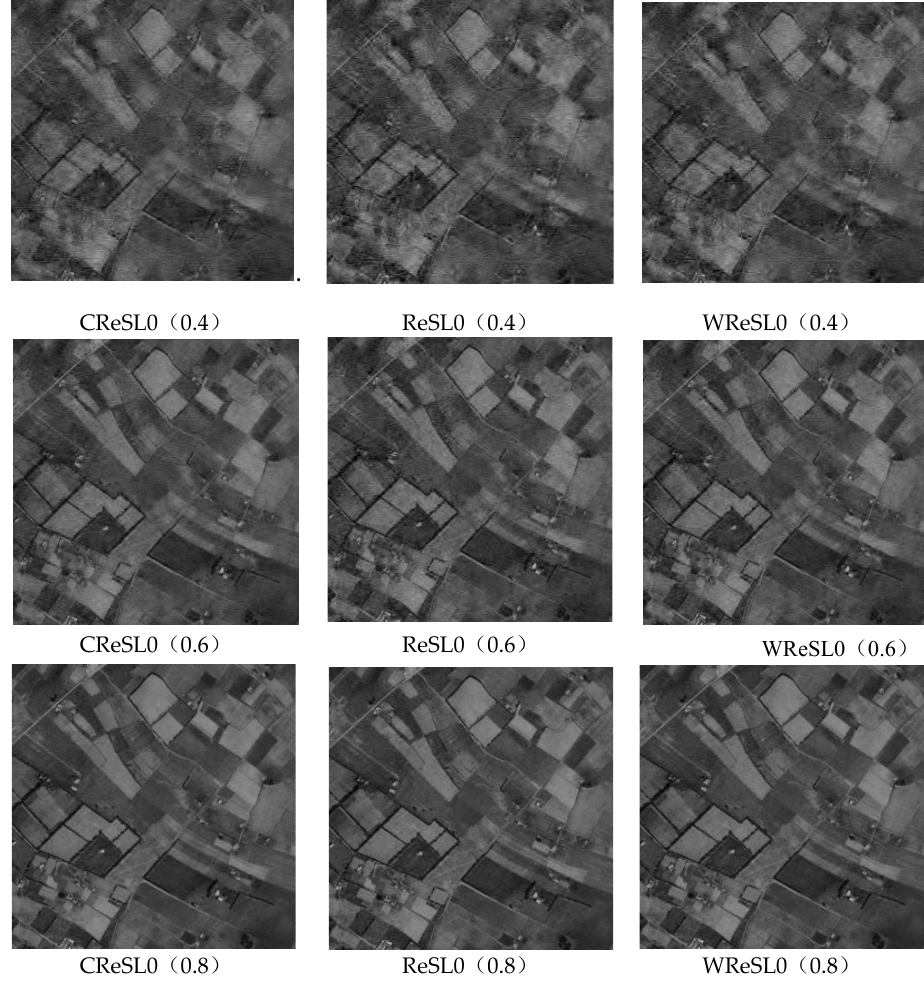
Figure. 5. Reconstructed images of each algorithm for different compression ratios. Figure 5. Reconstructed images of each algorithm for di ff erent compression